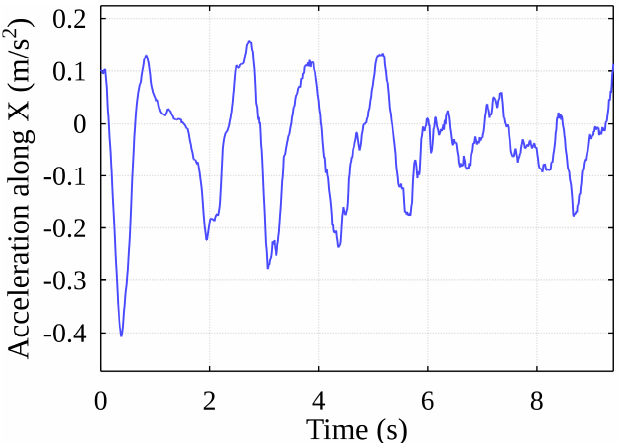
Figure 14. Acceleration of container along X-axis (handling cycle).